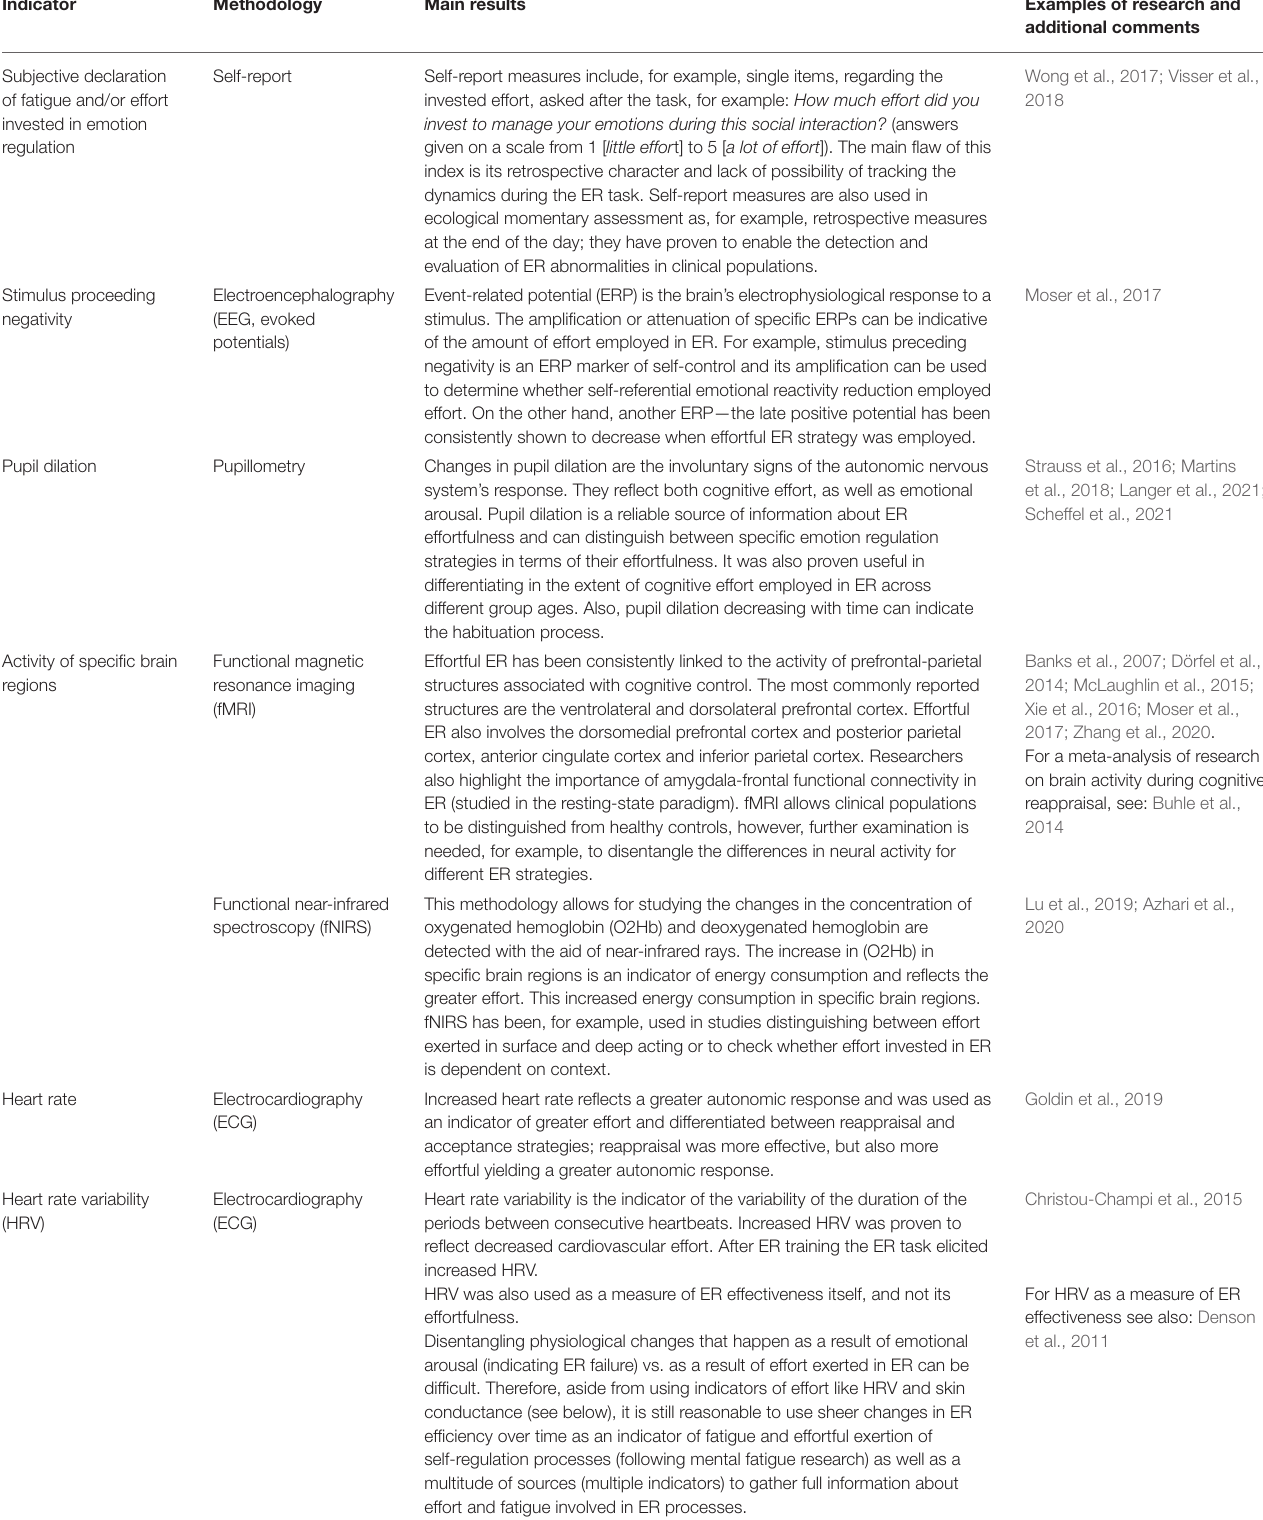
TABLE 1 | Indicators of emotion regulation effort (other than changes in sheer ER effectiveness) in available studies—examples of use.